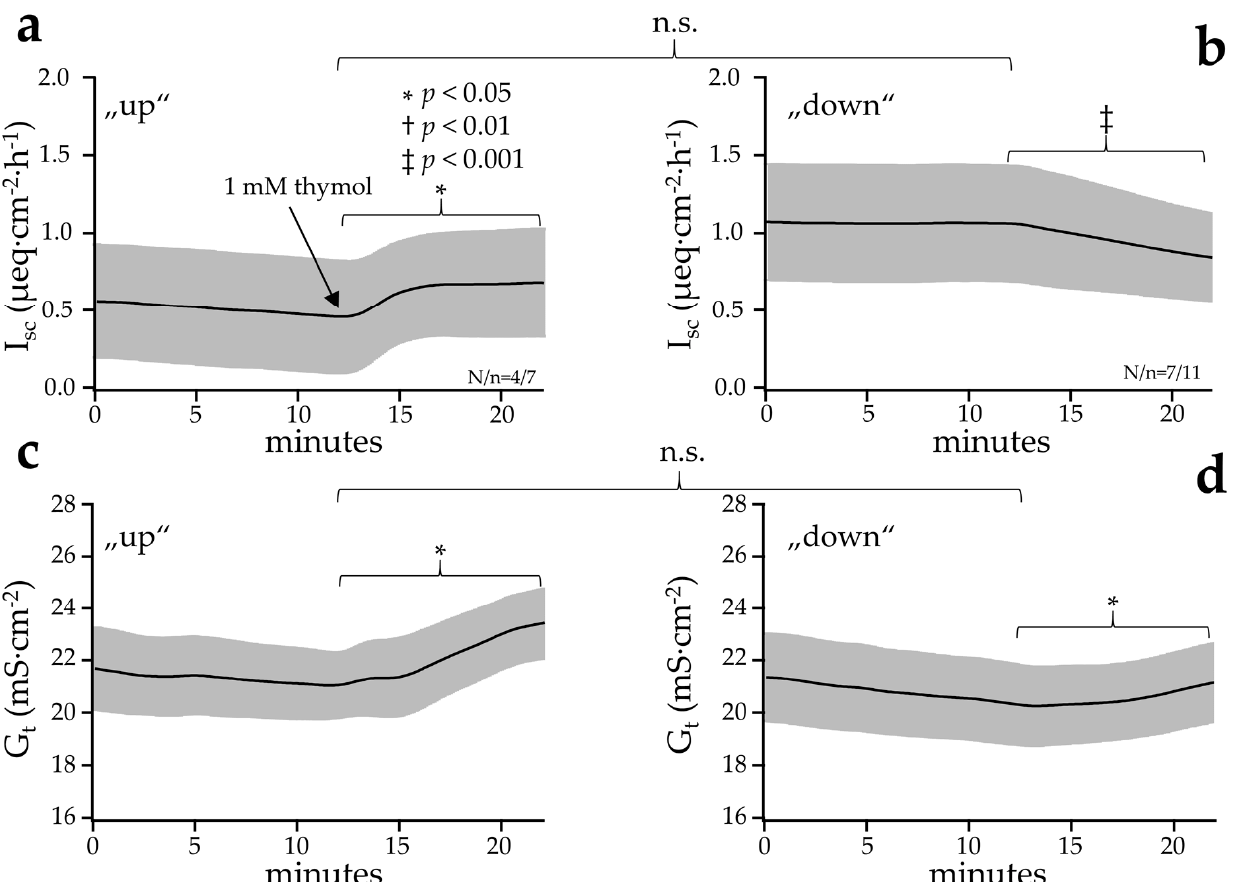
Figure 5. Effect of a bilateral application of thymol on the I sc and G t of the colon of ten young pigs (controlled in-house study). The data are given as means ± SEM. In some of the tissues, an increase (“up“) in I sc could be observed after the addition of thymol ( a ), whereas in other tissues a decrease or no effect (“down“) was observed ( b ). An increase in G t was observed in all of the tissues after the addition of thymol, ruling out barrier effects for increases in I sc ( c , d ). The significance bars within graphs compare values taken immediately prior to addition of the agonist and after an incubation of 10 min. The significance bars between graphs indicate that in the colon, there was no difference between the “up” and the “down” groups before thymol was added. Significant differences are marked as *, †, or ‡ ( P < 0.05, P < 0.01 or P < 0.001).